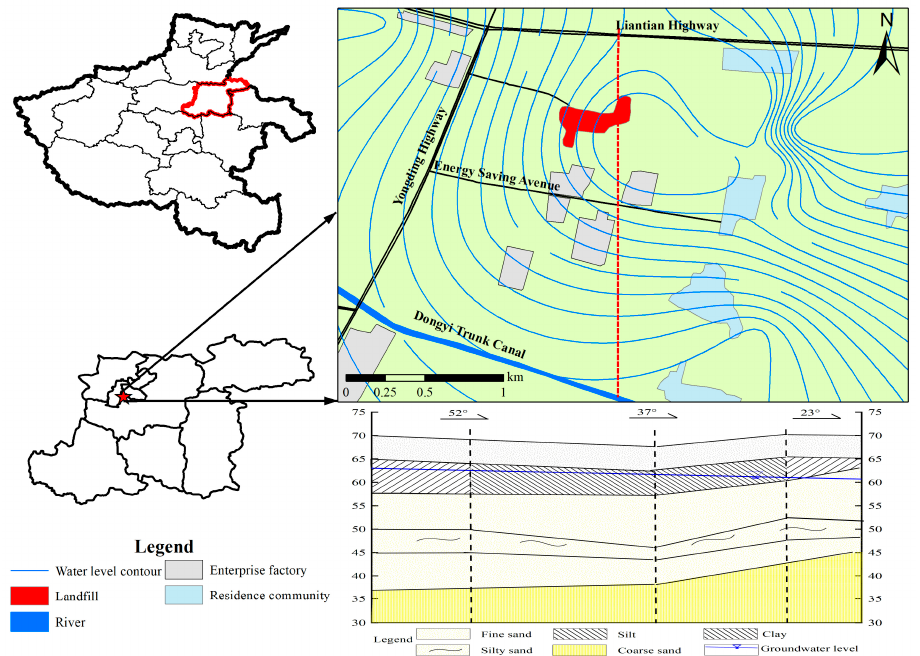
Figure 1. Overview of the study area and hydrogeological profile.